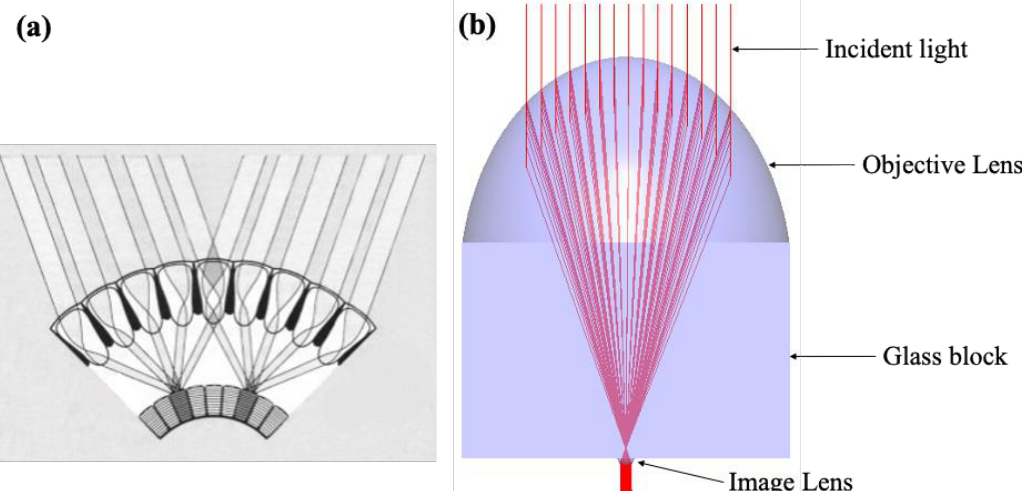
Figure 2. ( a ) Scheme showing how the superposition compound eye focuses light onto the retina. ( b ) Photograph of the light concentrator inspired by the eye of a moth, consisting of two lenses (objective and image lenses) and a glass block, and ray-tracing simulation indicating the parallel wide beam transform to the narrow beam.